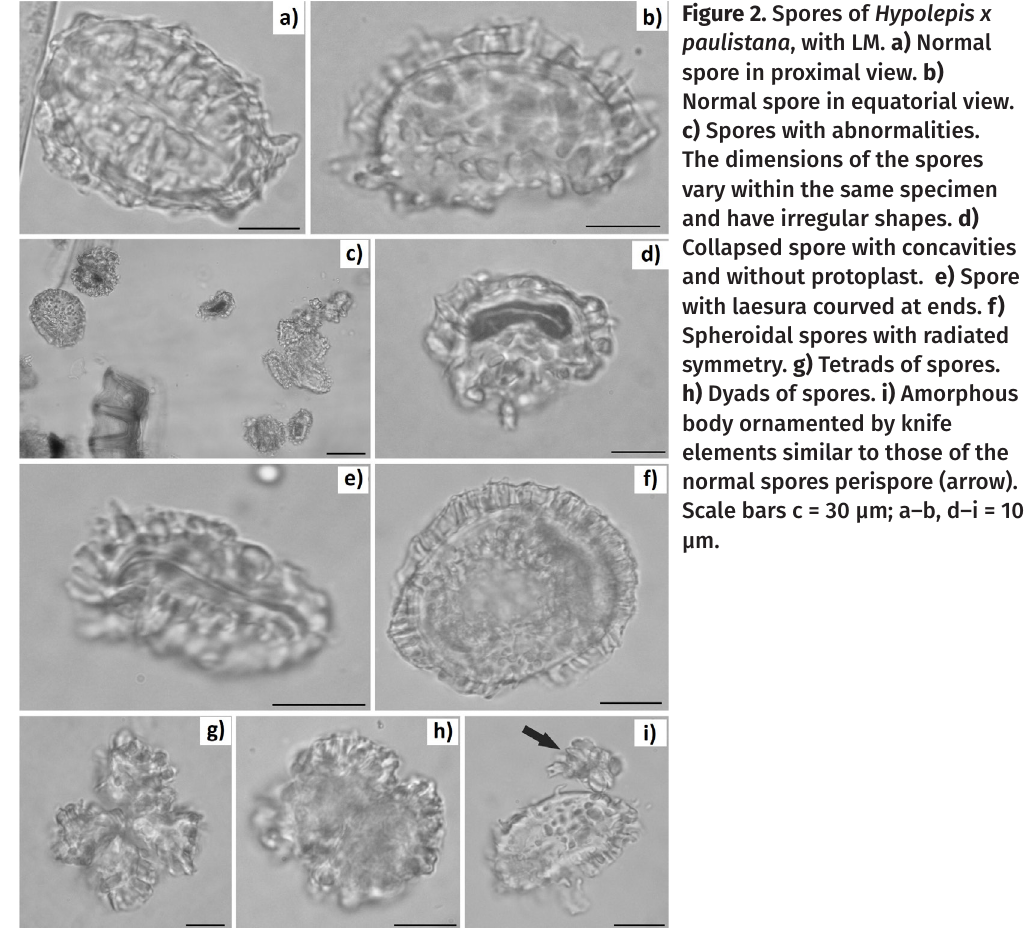
Figure 2. Spores of Hypolepis x paulistana , with LM. a) Normal spore in proximal view. b) Normal spore in equatorial view. c) Spores with abnormalities. The dimensions of the spores vary within the same specimen and have irregular shapes. d) Collapsed spore with concavities and without protoplast. e) Spore with laesura courved at ends. f) Spheroidal spores with radiated symmetry. g) Tetrads of spores. h) Dyads of spores. i) Amorphous body ornamented by knife elements similar to those of the normal spores perispore (arrow). Scale bars c = 30 µm; a–b, d–i = 10